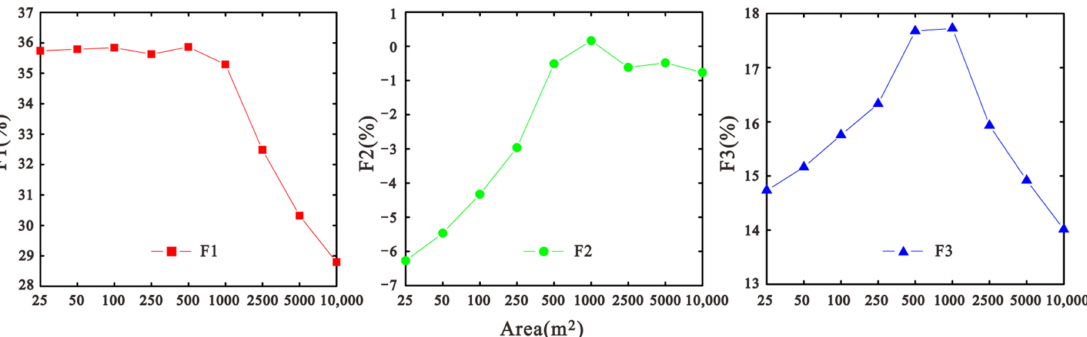
Figure 3. The three types of indicators: F1, F2 and F3, as a function of the extraction area.